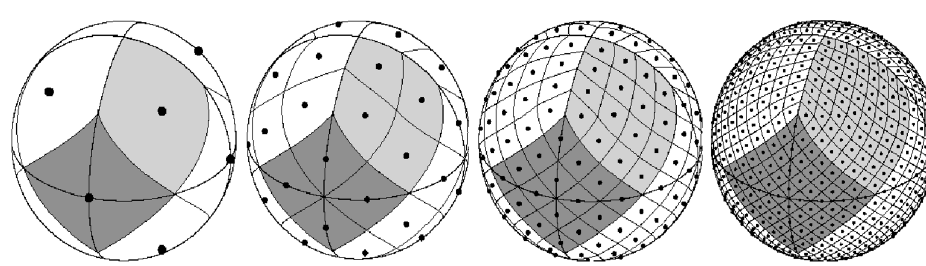
Figure 1. Orthographic views for the results produced by the HEALPix partitioning scheme. The illustration is adapted from a representation originally available from the HEALPix